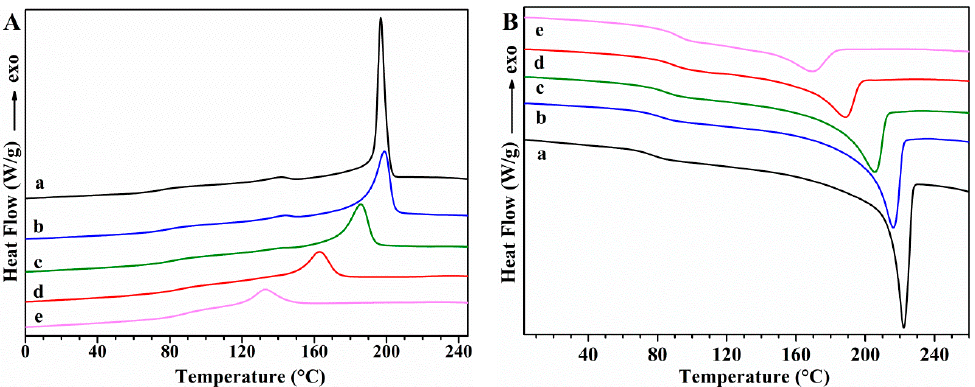
Figure 6. DSC curves: ( A ) first cooling; ( B ) second heating for unplasticized (a) PVA; (b) PVA/GS0.5; (c) PVA/GS1; and (d) PVA/GS1.5; (e) PVA/GS2.